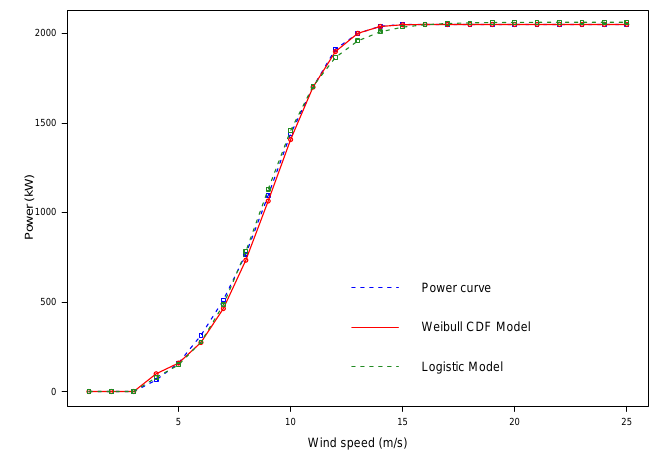
Figure 4. Weibull CDF and 4P-OP models for the REpower 82 2050-kW power